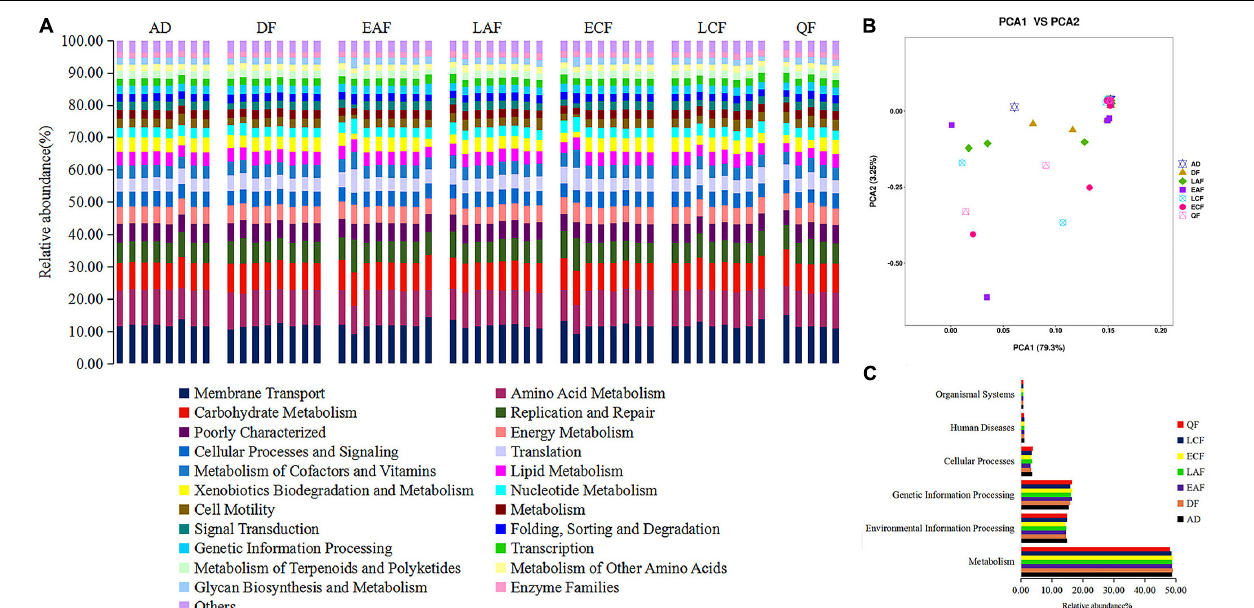
FIGURE 4 | Functional predictions of all samples using PICRUSt. (A) Variations in functional gene families across seven groups. (B) Principal component analysis (PCA) showing microbial functional diversity across all samples. (C) Histogram showing the six categories of gene pathways across seven groups. AD refers to eight samples from adult birds; DF refers to eight samples from the downy feather stage; EAF refers to eight samples from the early acicle feather stage; LAF refers to eight samples from the later acicle feather stage; ECF refers to eight samples from the early contour feather stage; LCF refers to eight samples from the later contour feather stage; QF refers to five samples from the qi feather